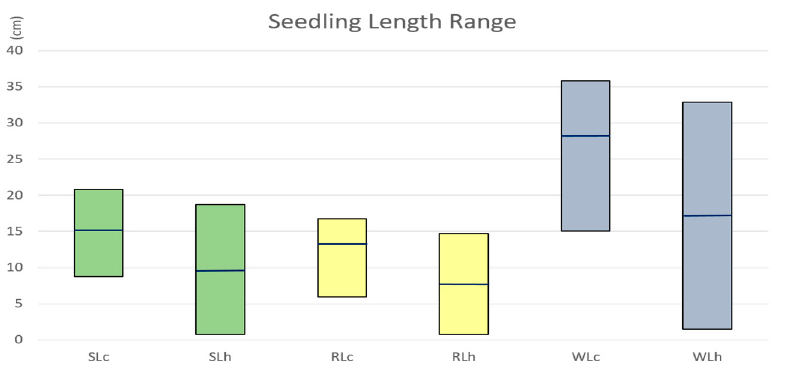
Figure 1. Comparison of seedling length under control and under heat stress. SL c , RL c , and WL c indicate shoot length, root length, and whole seedling length under control, respectively; SL h , RL h , and WL h indicate shoot length, root length, and whole seedling length under heat stress, respectively. Shoot, root, and whole length are shown in green, yellow, and blue colors, respectively. The top and bottom of the boxes show the minimum and maximum of length in the population, and the horizontal lines in the middle of the boxes show the average of length in the population.